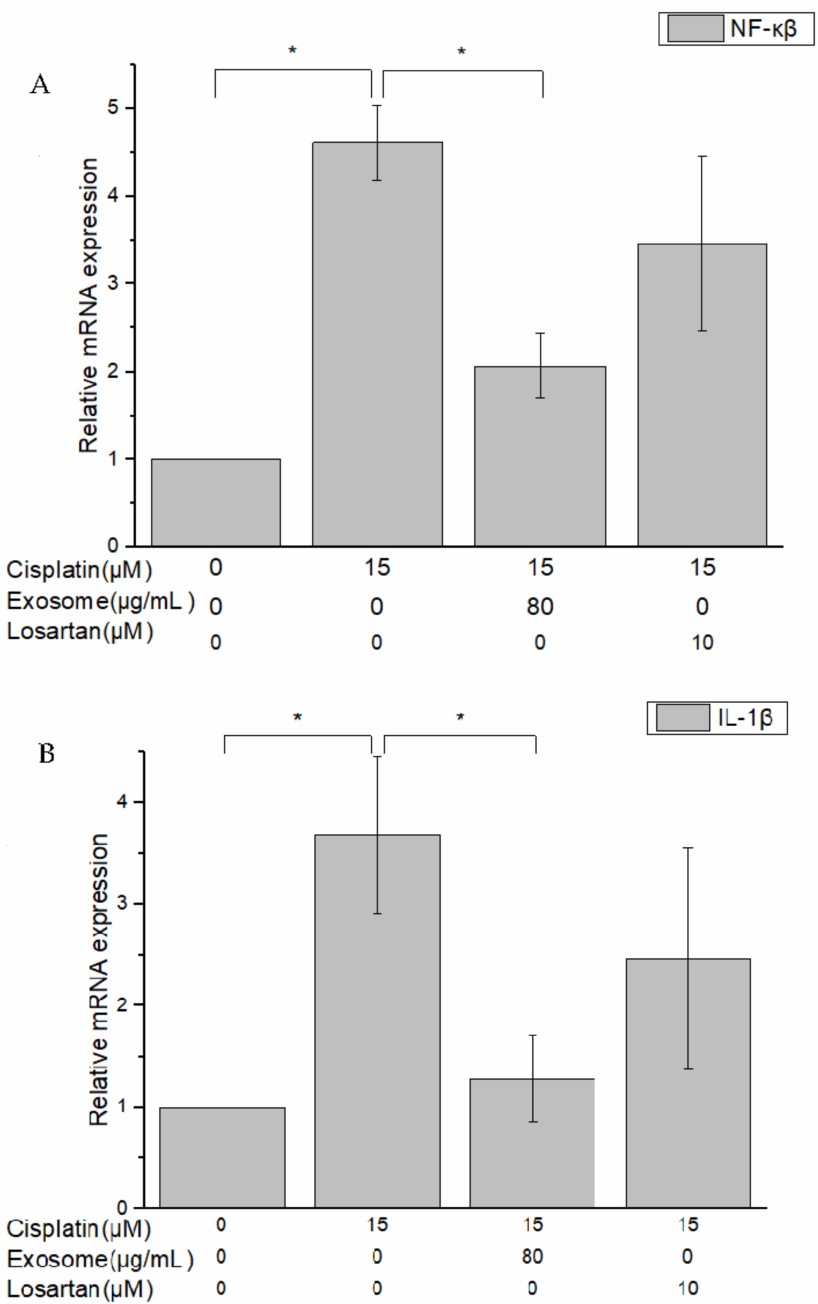
Figure 6. Gene-expression levels of NF- κβ ( A ) and IL-1 β ( B ) in cisplatin-treated NRK-52E cells after pretreatment with SCAP-ex or losartan, measured via qRT-PCR assay. Values are expressed as mean ± SD ( n = 3), * p < 0.05 for compared with cisplatin-treated group. IL-1 β , interleukin-1 β ; NF- κβ , nuclear factor- κβ ; qRT-PCR, quantitative reverse transcription–polymerase chain reaction; SCAPs, stem cells from the apical papilla; SCAP-ex, SCAP-derived